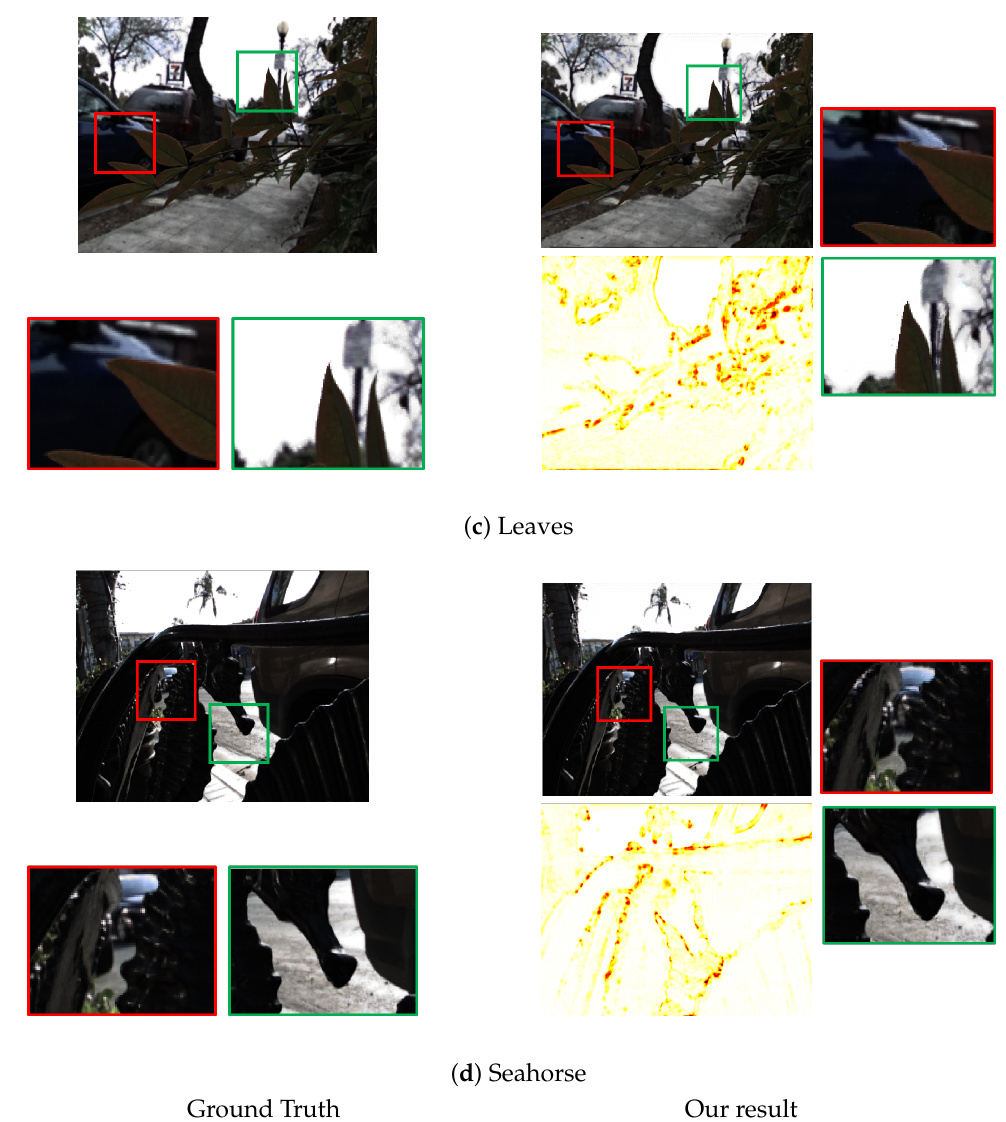
Figure 13. Visual analysis for the ‘Car’, ‘Flower’, ‘Leaves’ and ‘Seahorse’ images’ synthesized leftmost horizontal sub-aperture view and the SSIM map with the ground-truth sub-aperture view for the proposed